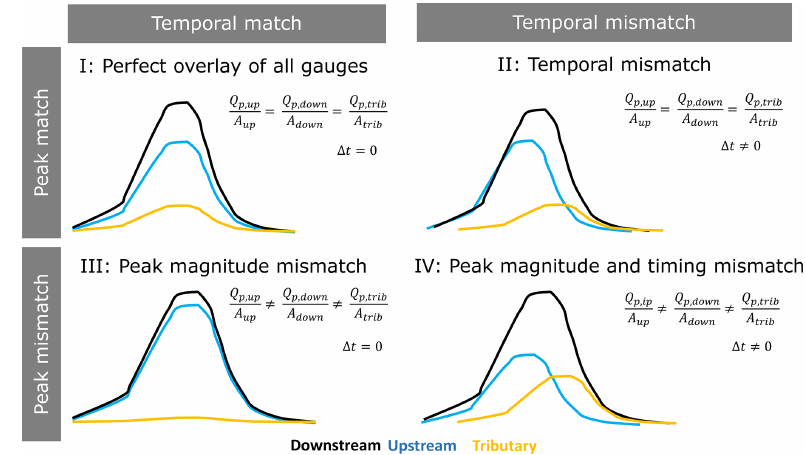
Figure 3. Comparison of the four types of flood wave superposition shown for four combinations of matches and mismatches in peak magnitude and peak timing.